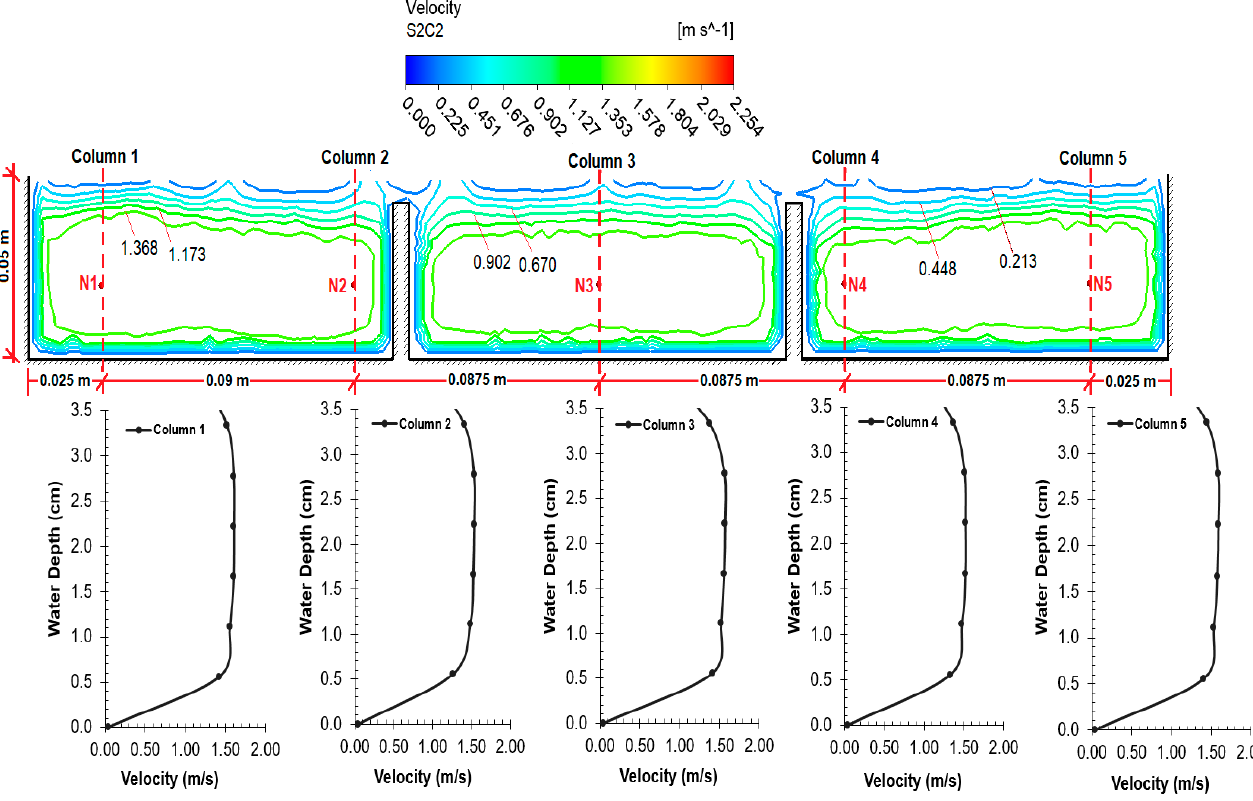
Figure 16. CFD velocity contours and depth-velocity distributions for Cross-section 2.